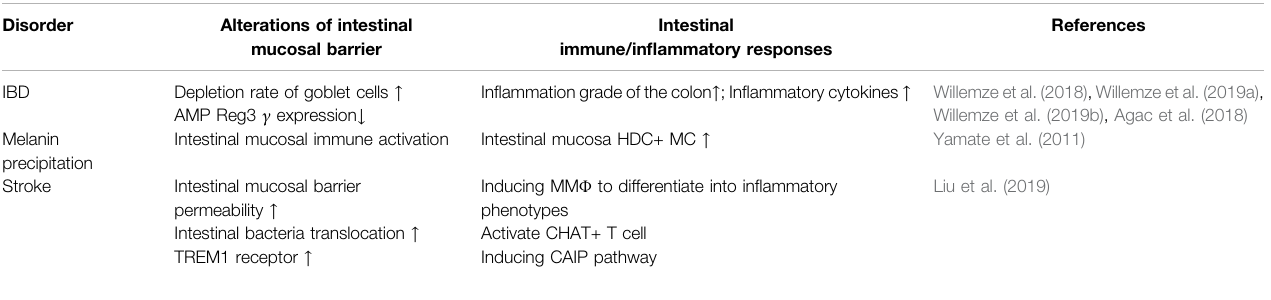
TABLE 1 | Summary of SNS-intestinal immunity manifestations in different diseases.